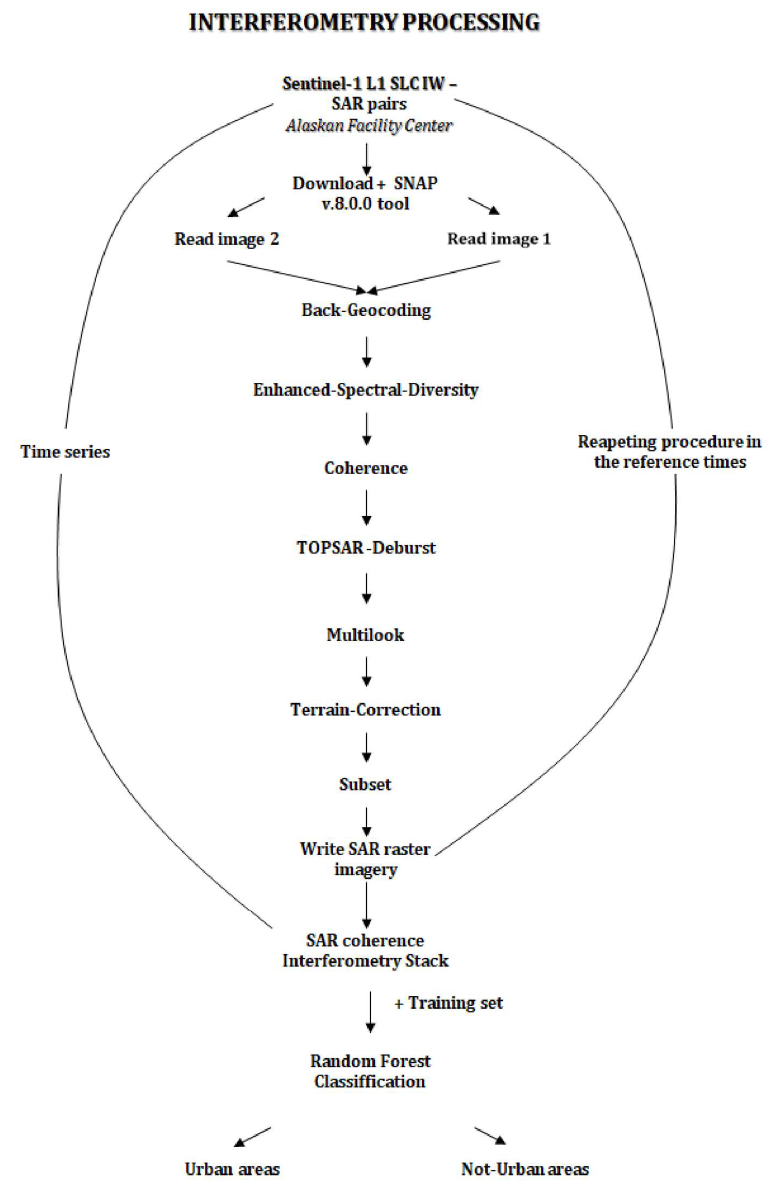
Figure 3. Interferometry in ESA SNAP v.8.0.0 and classification VH and VV were